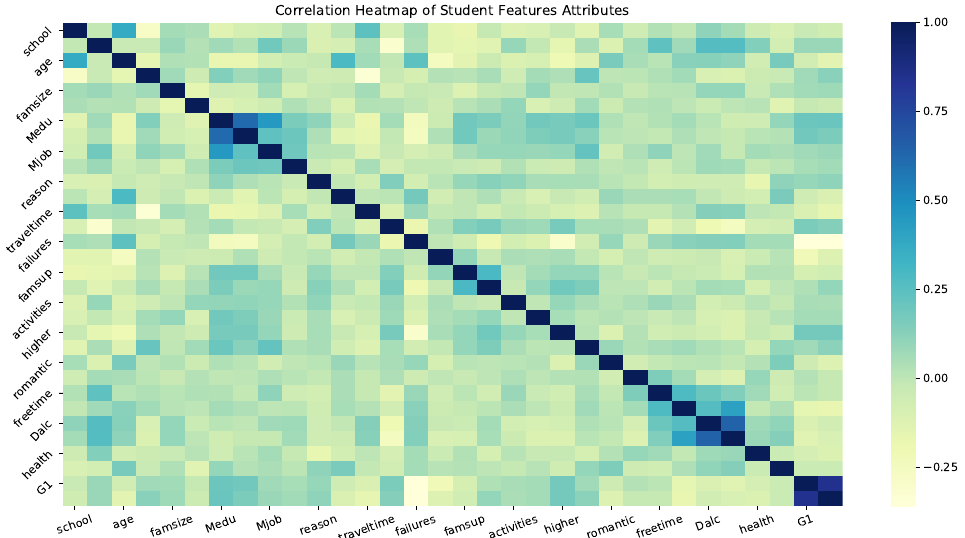
Figure 10. Heatmap of student features